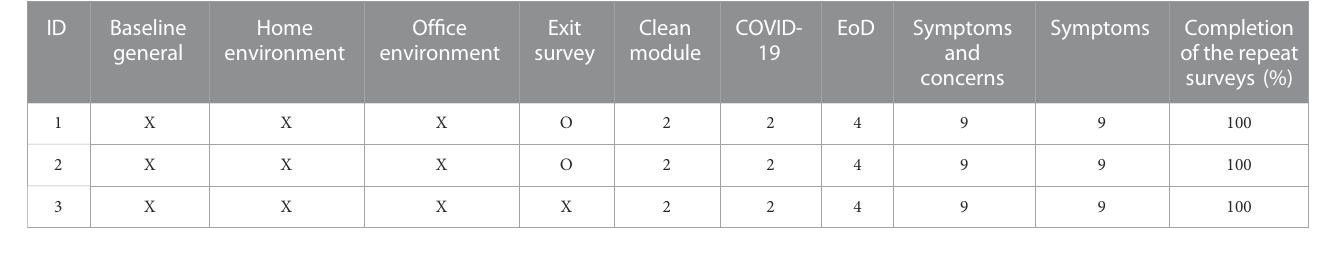
TABLE 2 Response rate.